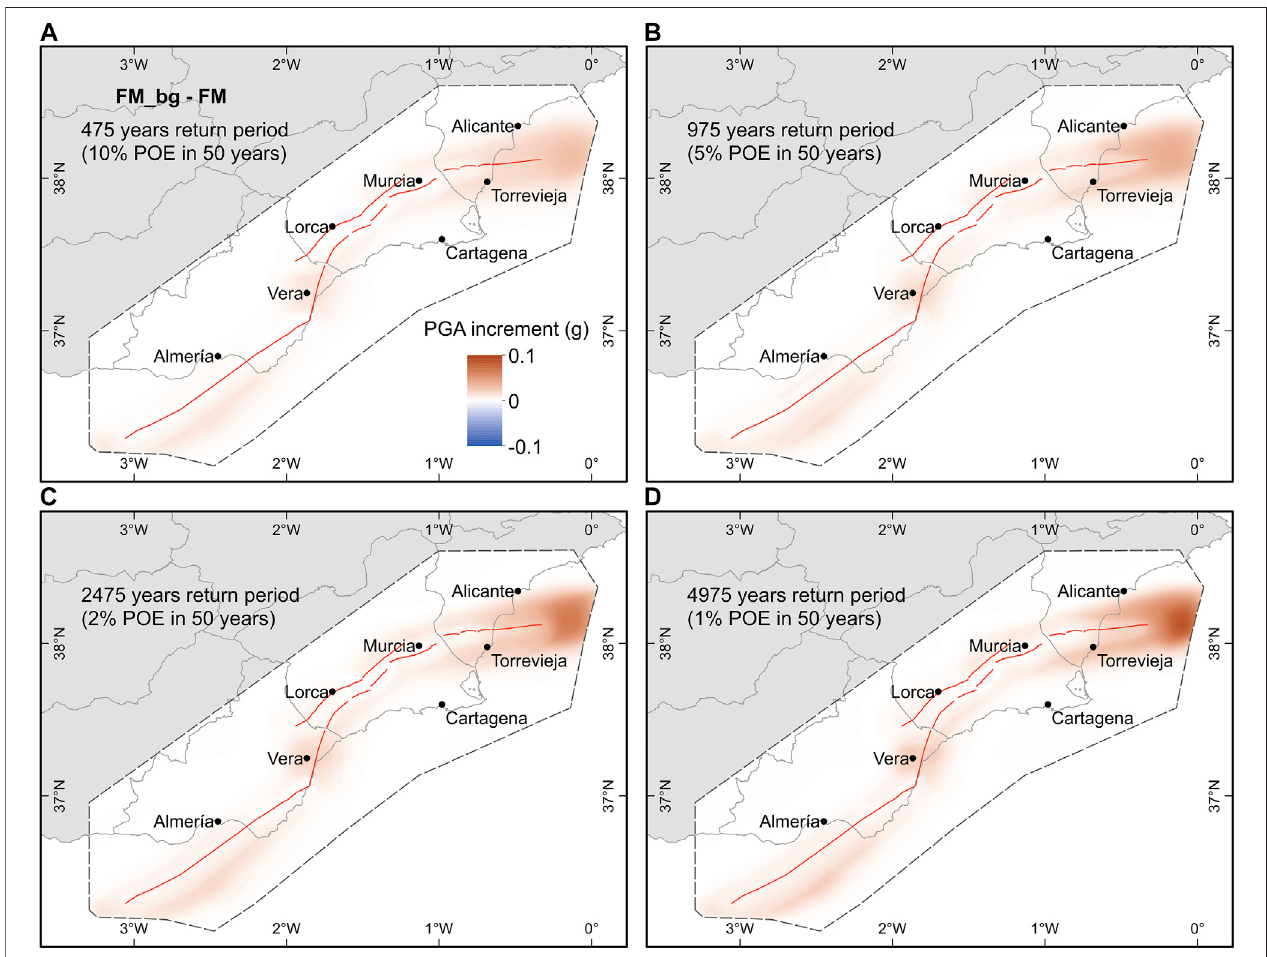
FIGURE 8 | (A) Difference (in g) of the mean hazard maps from the FM_bg model ( Figure 5 ) respective to the FM model ( Figure 4 ) for the return periods of 475 years; (B) 975 years; (C) 2,475 years, and; (D) 4,975 years. A common color scale is set for all return periods. The traces of the EBSZ faults considered are depicted in